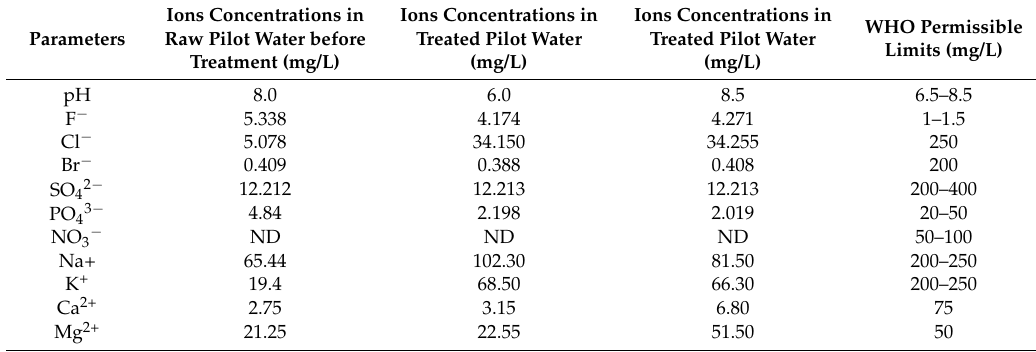
Table 7. Physicochemical properties of raw and treated pilot fluoride rich